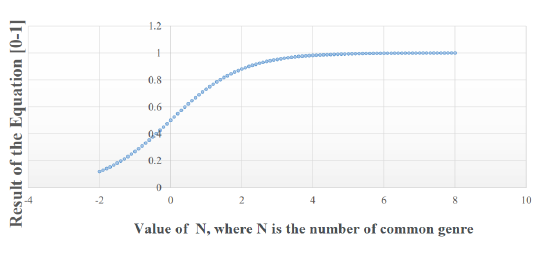
Figure 2. Graph of sigmoidal activation